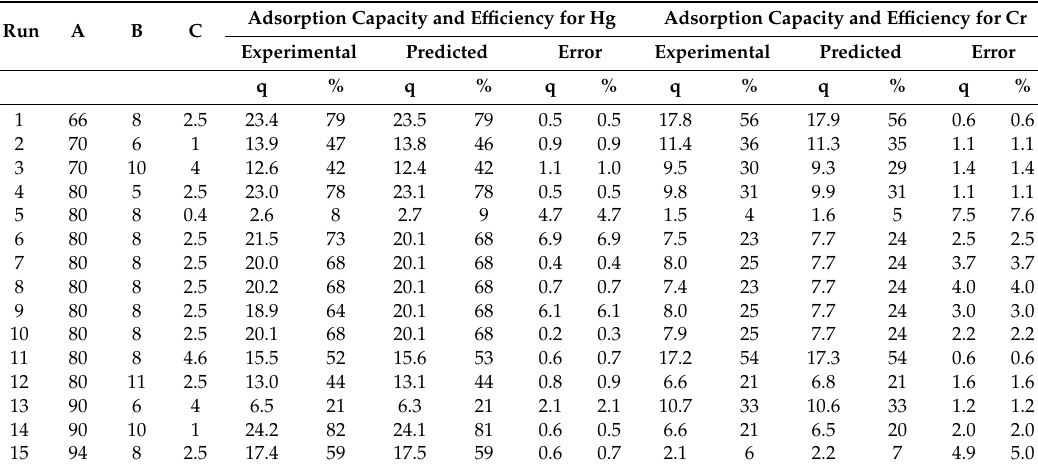
Table 2. Results of Central Composite Design (CCD) for WPF preparation and its impact on mercury and chromium removal from water, experimental and analytical response. Factors: